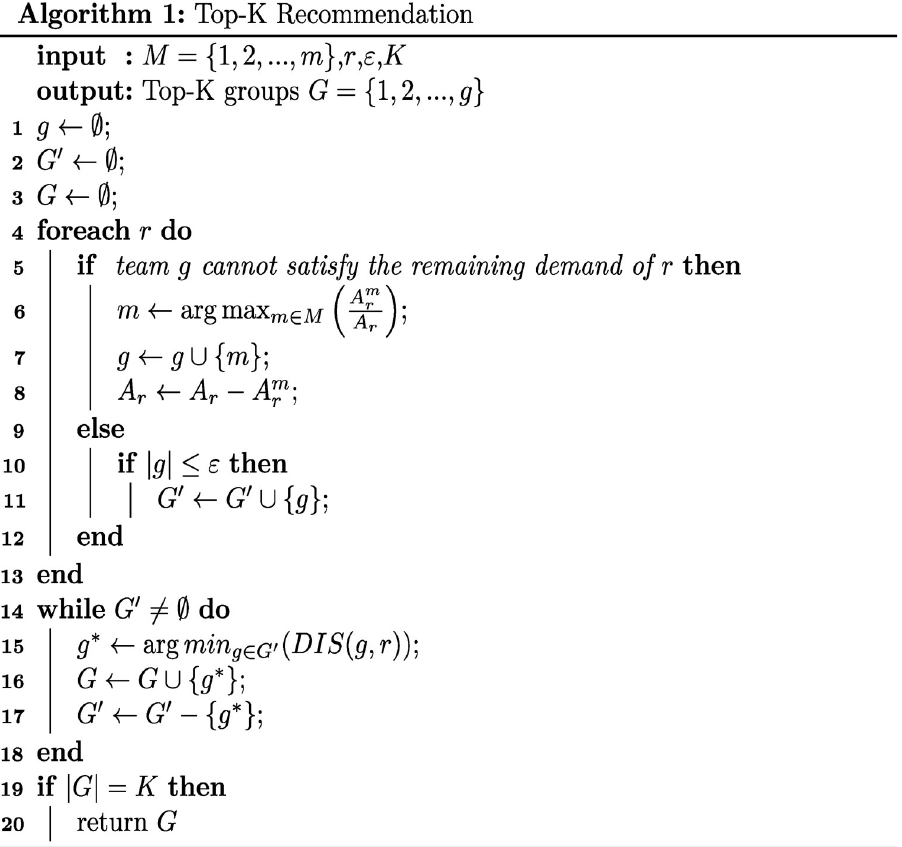
Fig 5. Top-K recommendation. It shows the pseudo code for Algorithm